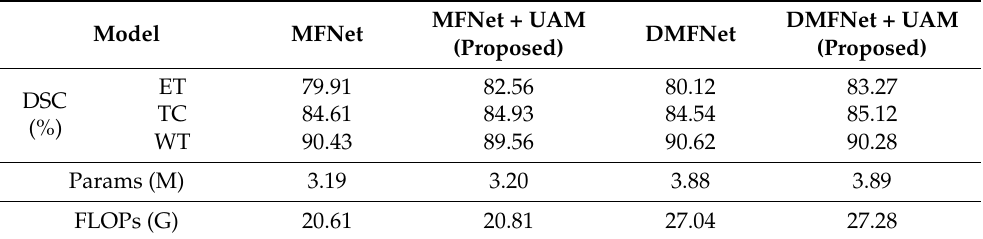
Table 1. Evaluation results of baseline and the proposed method. DSC = dice coefficient; ET = enhancing tumor; TC = tumor core; WT = whole tumor; Params = number of model parameters; FLOPs = floating-point operations per